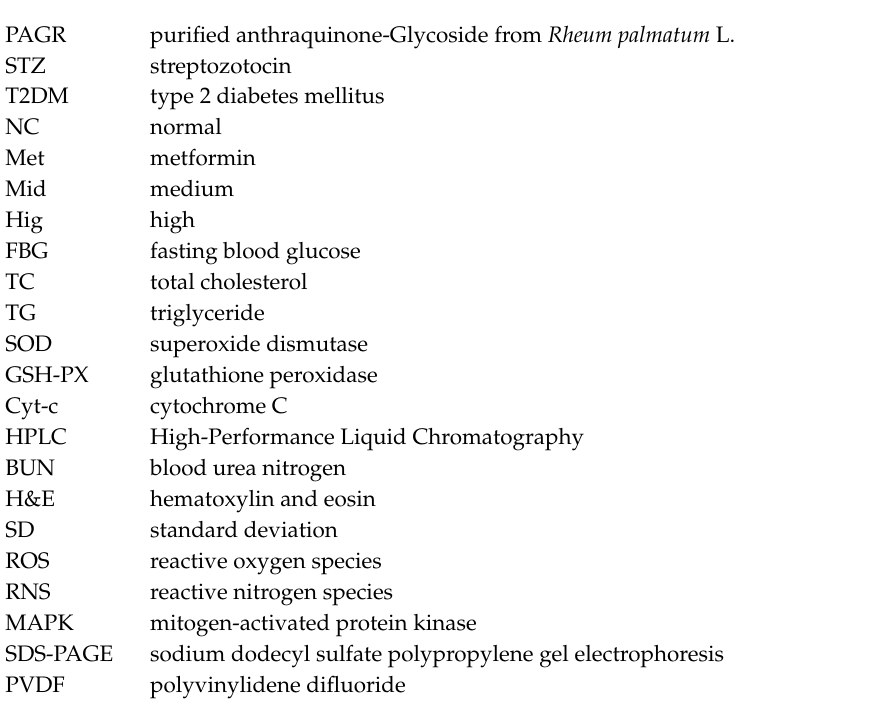
Supplementary Materials: The following are available online, Table S: Data of Serum indicators (FBG, TC, TG, SOD, GSH-PX, creatinine and BUN) and body weight of